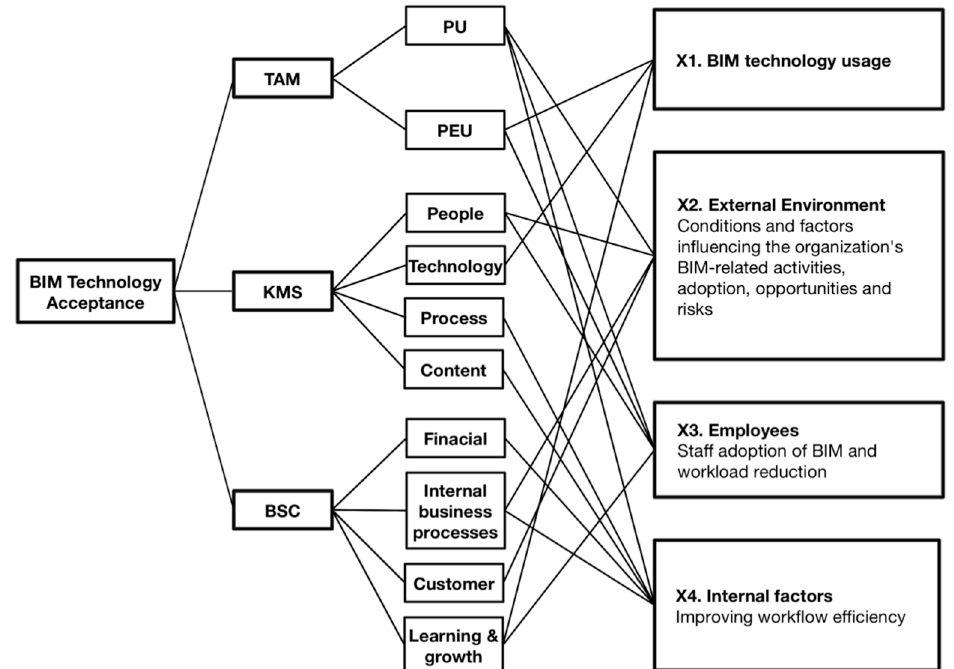
Fig. 1. The framework of BIM acceptance